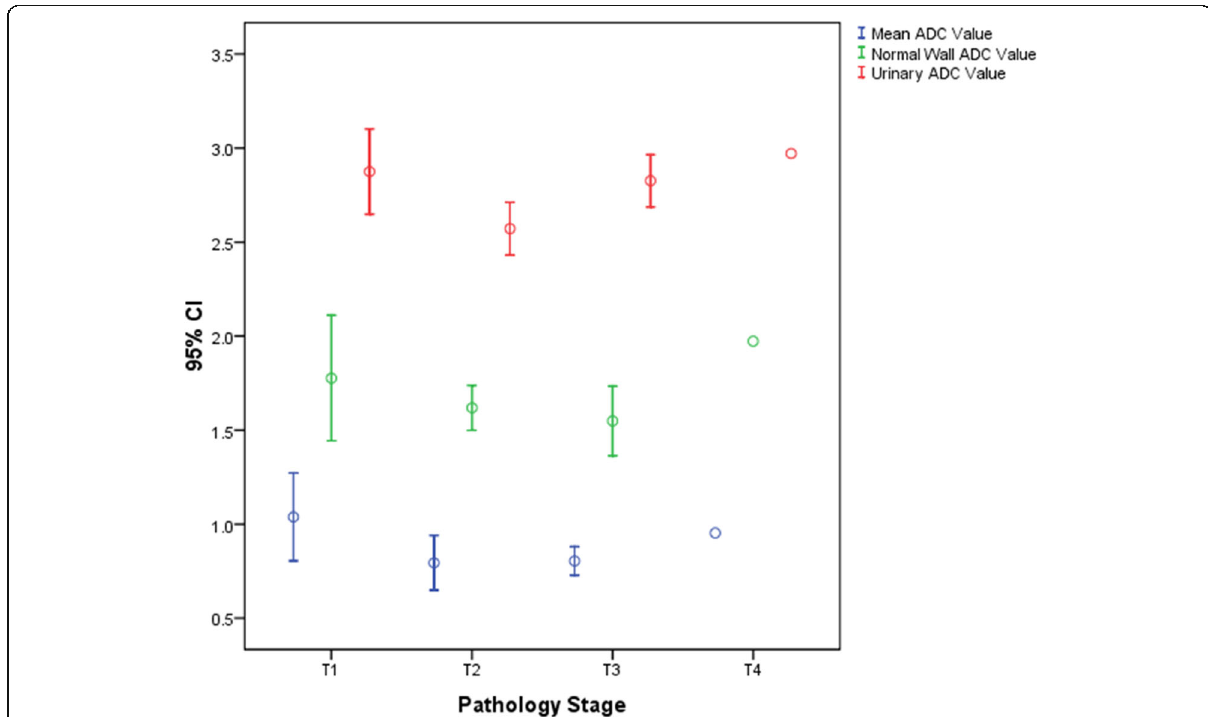
Fig. 1 Bar chart of mean ADC of lesion, normal wall, and urine according to pathology